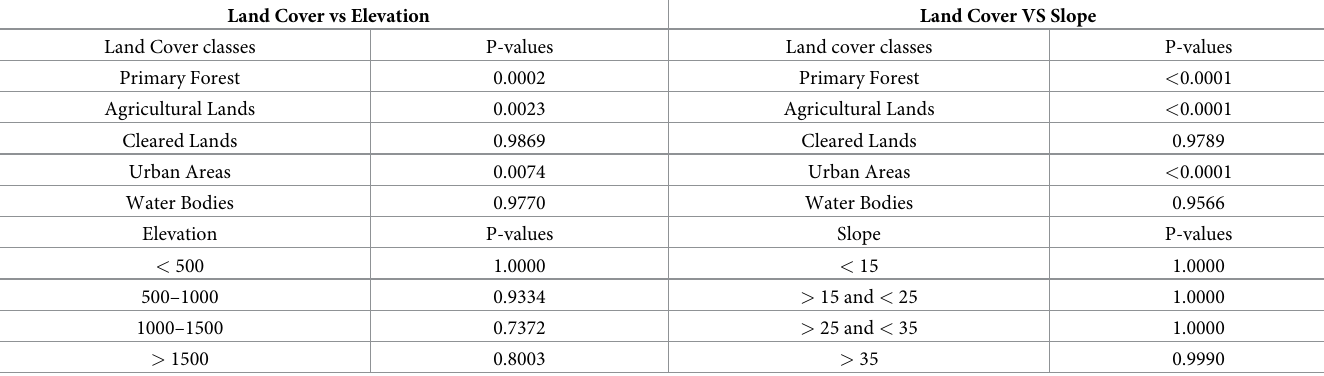
Table 10. Non-parametric ANOVA test of significance on land cover changes